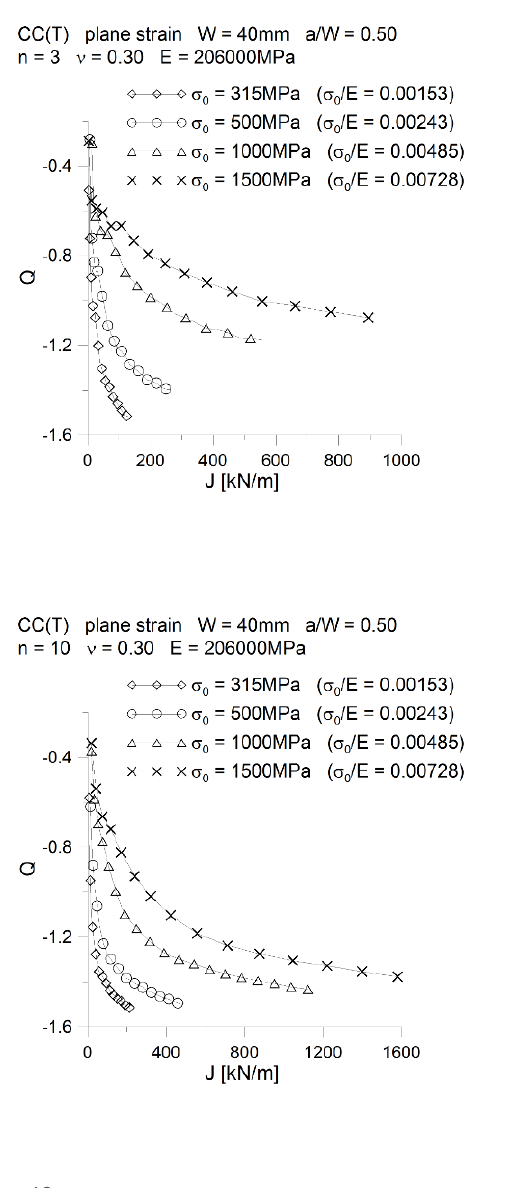
Figure 19. The influence of the yield stress on J - Q trajectories for CC(T) specimens with crack length a / W =0.50 for different power exponents in R-O relationship: a) n =3; b) n =5; c) n =10; d) n